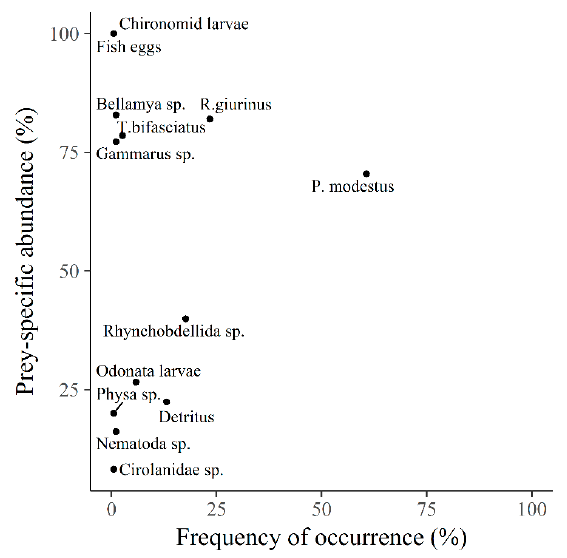
Figure 2. Percentage of prey-specific abundance and frequency of occurrence of prey items of the Shimofuri goby ( Tridentiger bifasciatus ) in Nansi Lake, China.